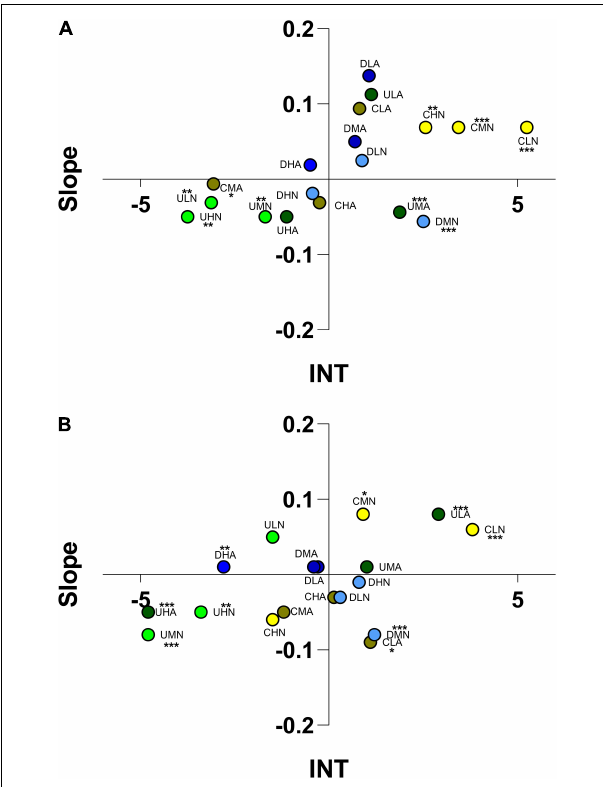
FIGURE 6 | Ordination into 1 of 4 sectors of Rissoa italiensis according to the scores reached for “Slope” and “INT” (integral time) in static arenas (A) and flow-through flumes (B) . The letters indicate the algae considered (C, Cocconeis scutellum var. parva ; D, Diploneis sp.; U, Ulva prolifera ), the concentration of VOCs (L, low; M, medium; H, high), and the culture and test conditions (N, normal conditions; A, acidified conditions). Asterisks indicate the significance of individuals’ position in the